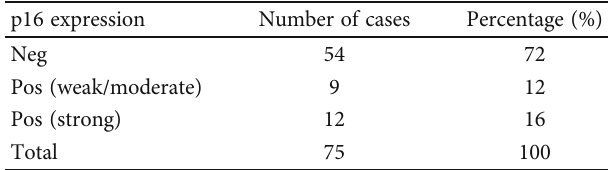
Table 2: p16 protein expression among the study